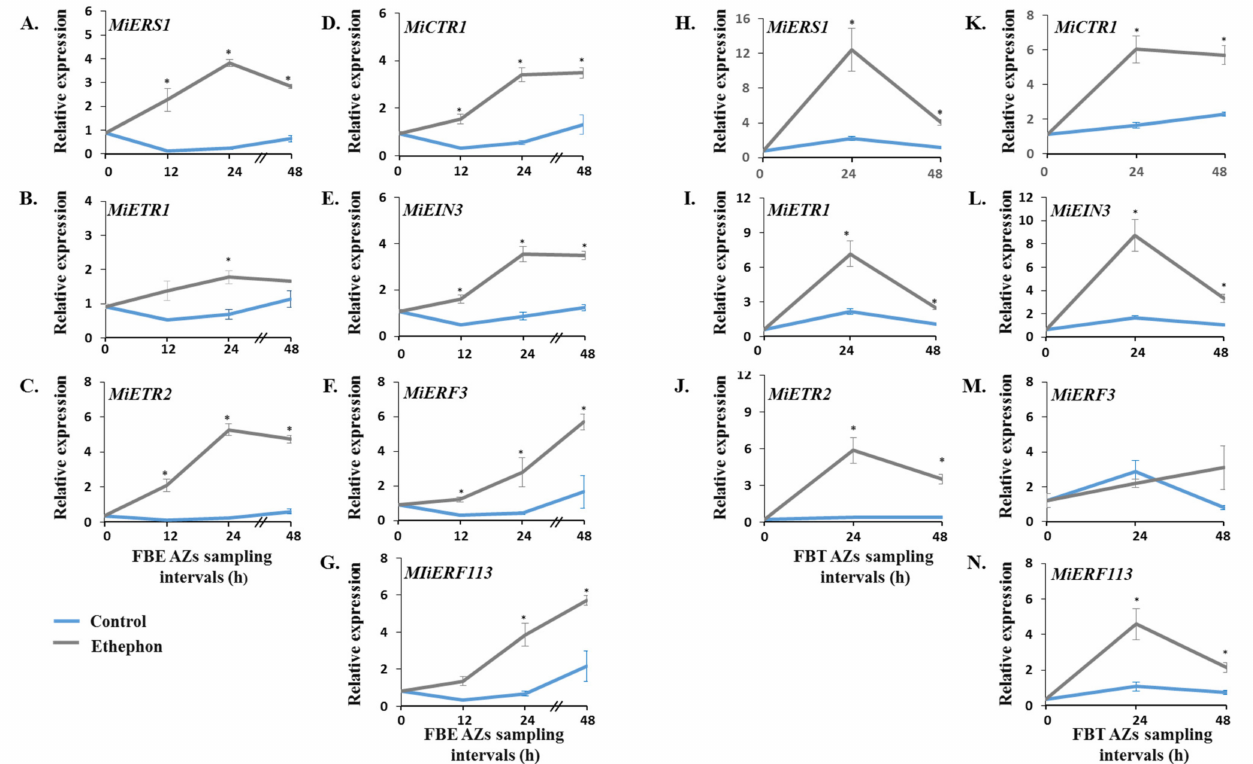
Figure 4. Effect of ethephon treatment on the expression profiles of seven ethylene signaling-related genes in mango fruitlet AZs of FBE ( A – G ) and FBT ( H – N ) during 48 h. Analysis of qRT-PCR was performed using cDNA prepared from total RNA extracted from FBE or FBT AZ tissues. Values represent relative expression levels normalized against the endogenous reference gene, MiGAPDH . For each group and time point, the data are presented as the means ± SE of three independent biological replicates, and two technical replicates. Asterisks (*) denote significant differences between ethephon-treated and control AZ samples at each sampling point ( p ≤